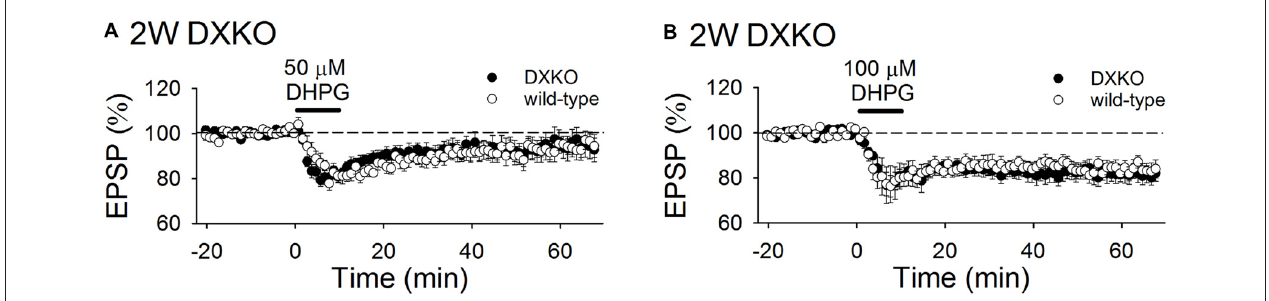
FIGURE 6 | DHPG-induced LTD is not enhanced in developing DXKO mice. (A) Average time course of 50 µ M DHPG-induced LTD in 2-week-old WT ( n = 11 from four mice) and DXKO mice ( n = 14 from six mice). (B) Average time course of 100 µ M DHPG-induced LTD in 2-week-old WT ( n = 14 from four mice) and DXKO mice ( n = 9 from four